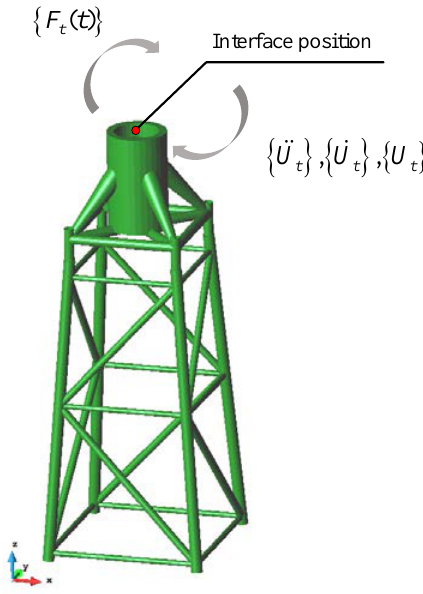
Figure 2. The concept of coupled analysis through the interface.